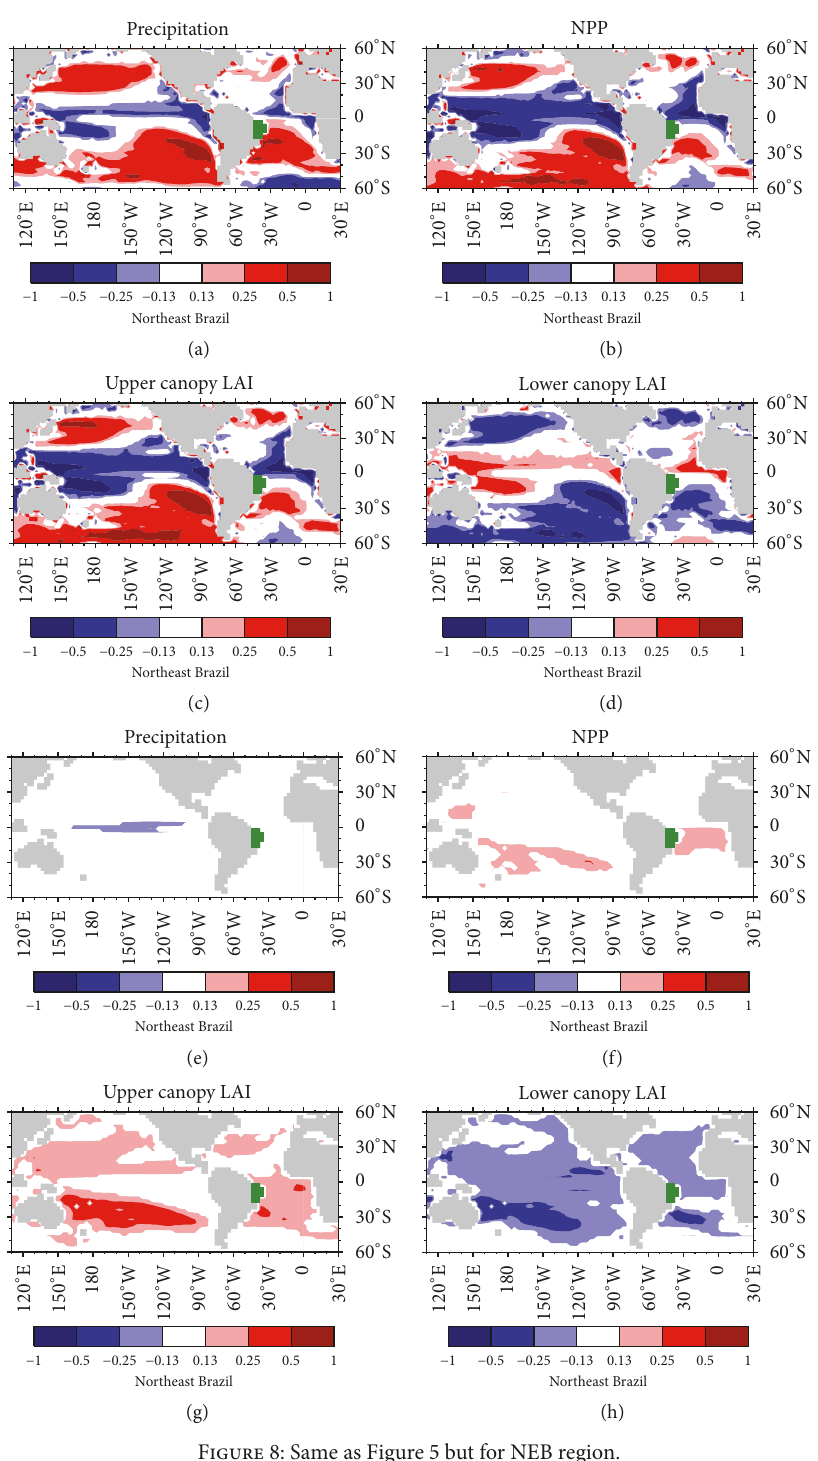
Figure 8: Same as Figure 5 but for NEB